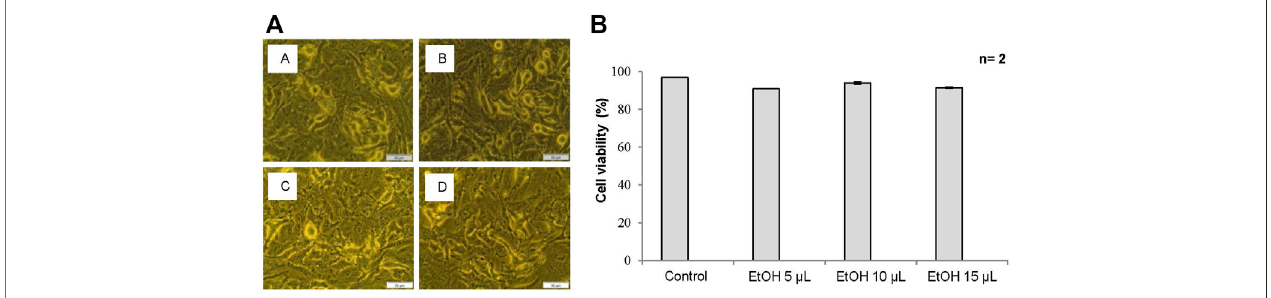
FIGURE 1 | (A) Cell morphology of A549 cells after exposure to different doses of 61% ethanol (EtOH) under an inverted light microscope (x200 Magni fi cation). Figure1A Untreated control, (B) 5 µlEtOH, (C) 10 µlEtOH, and (D) 15 µlEtOH. Scalebar 50 µm. (B) Thepercentage (%)ofviablecellsusingtrypanblue assayinA549 cells treated with 61% EtOH. Data is represented as the mean standard error